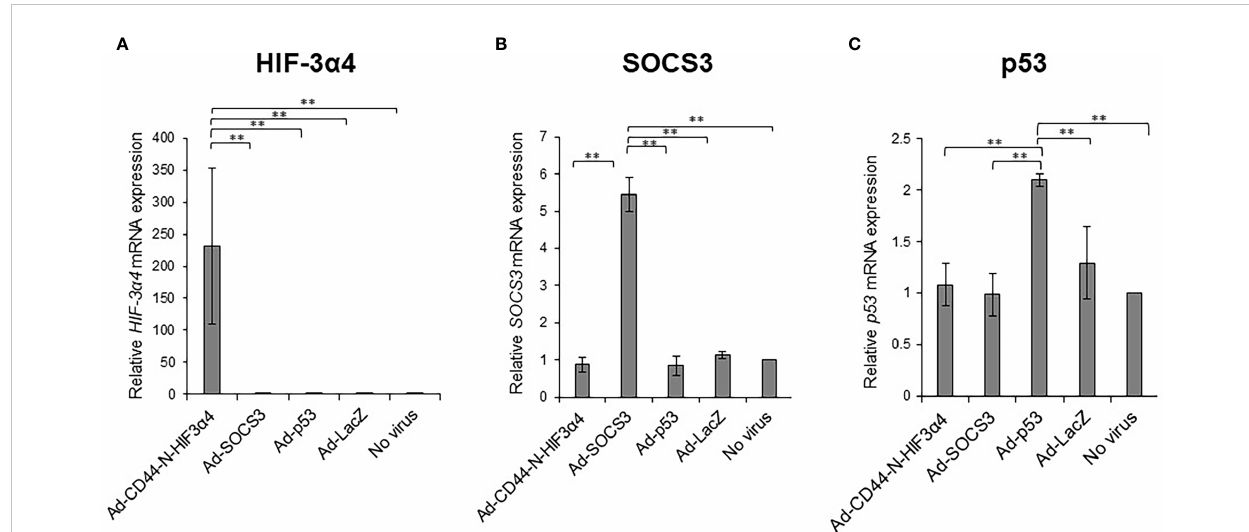
FIGURE 6 Gene expression of HIF-3 a 4 , SOCS3 and p53 induced by adenovirus vectors in MDA-MB-231 cells The gene expression of HIF-3 a 4 (A) , SOCS3 (B) and p53 (C) in MDA-MB-231 cells were measured by real-time RT-PCR after Ad-CD44-N-HIF3 a 4, Ad-SOCS3, Ad-p53 and Ad-lacZ infections. mRNA levels were